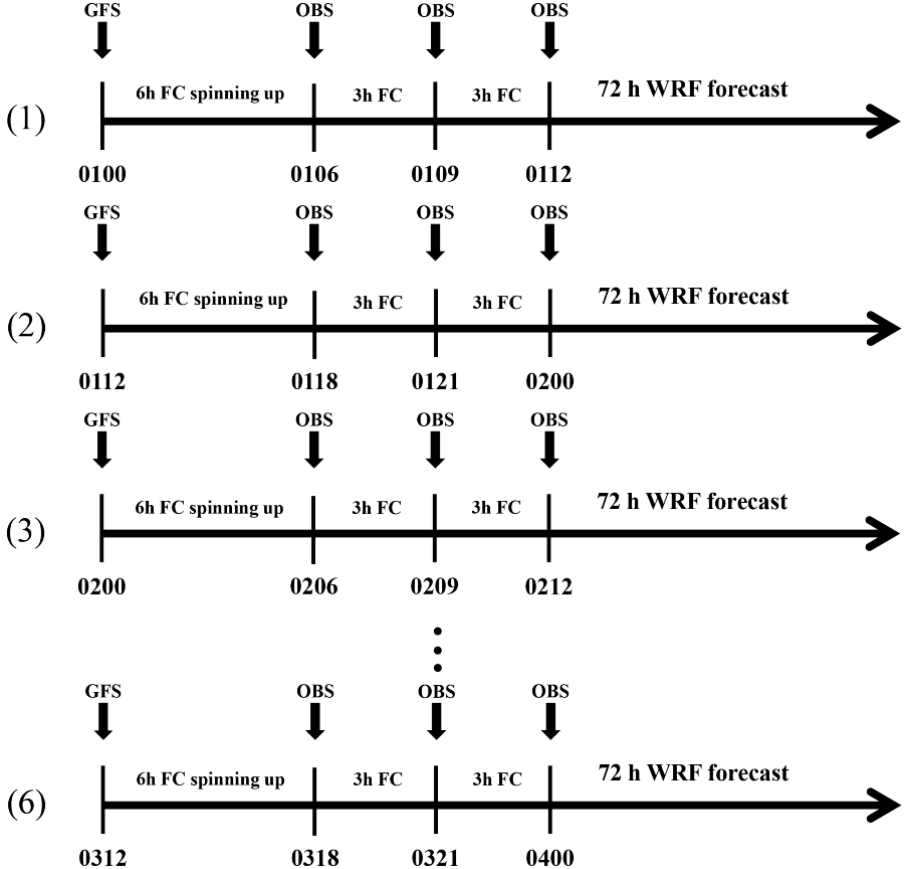
Figure 4. Flow charts of the 6 partially-cycling experiments, every 12 h updated, starting from 00:00 UTC 1 January 2019 to 12:00 UTC 3 January 2019, respectively.